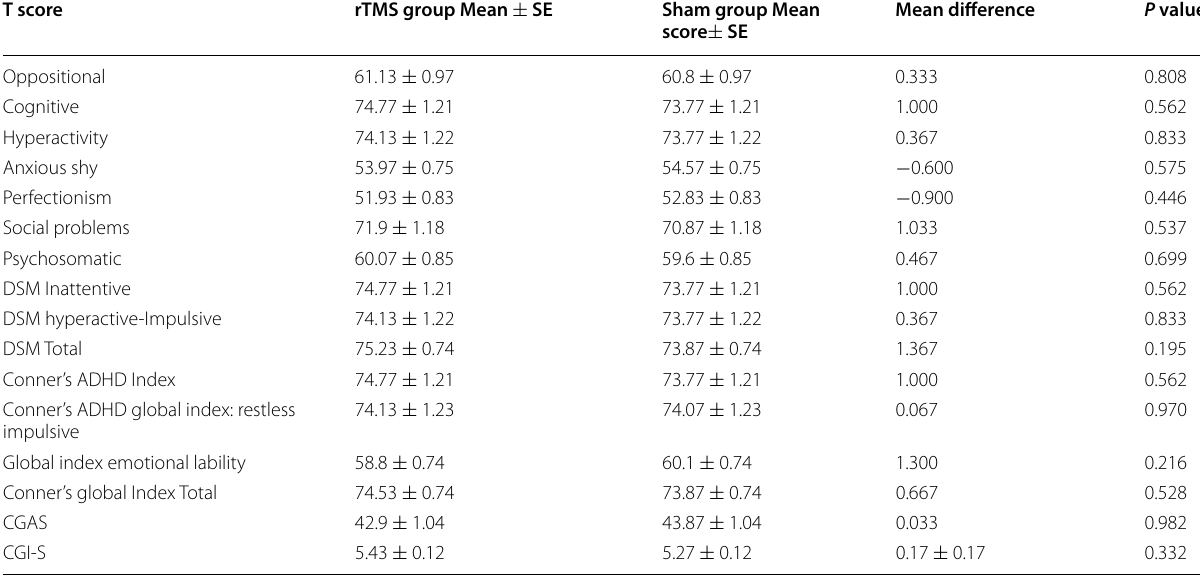
Table 2 Severity of ADHD symptoms measured by CPRS-R-L, CGAS, and